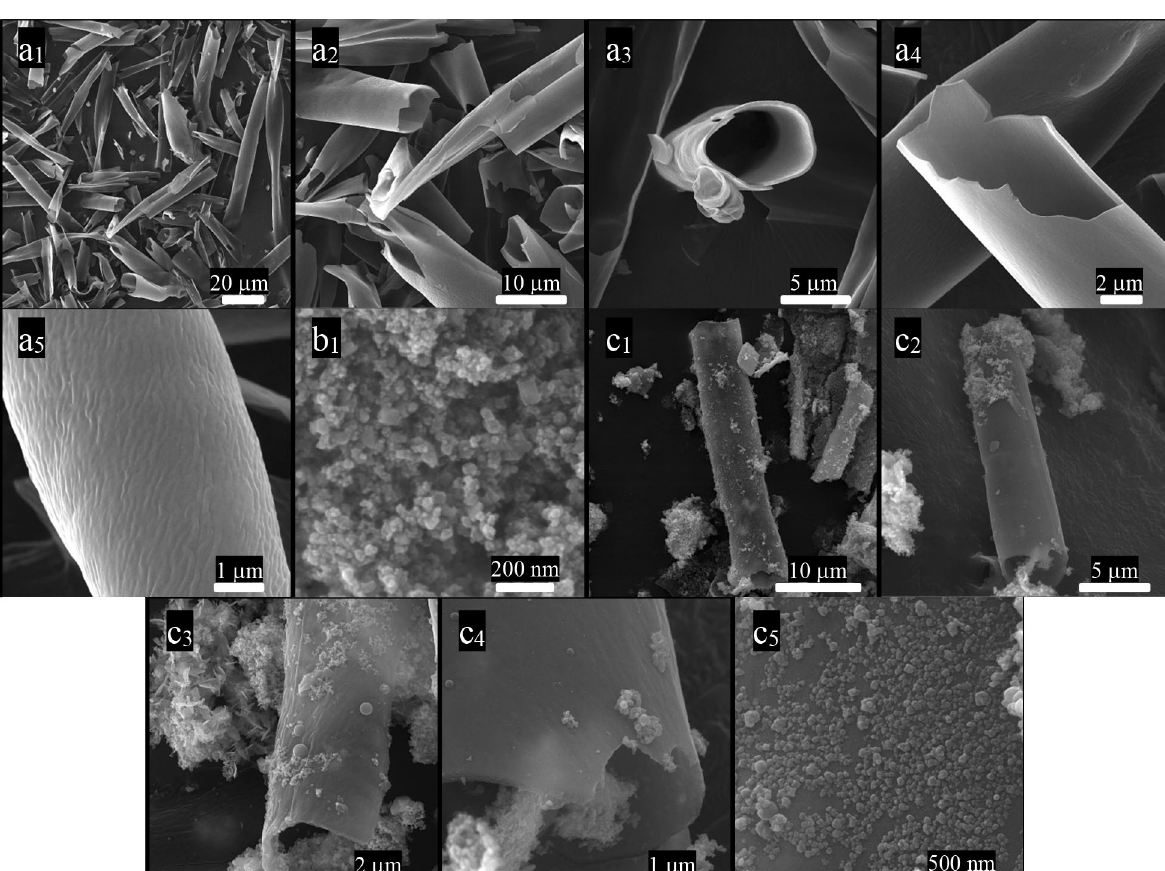
Figure 2. FTIR spectra ( a ) and XRD patterns ( b ) of FCMT, CuCo 2 S 4 , and FCMT/CuCo 2 S 4 structures.